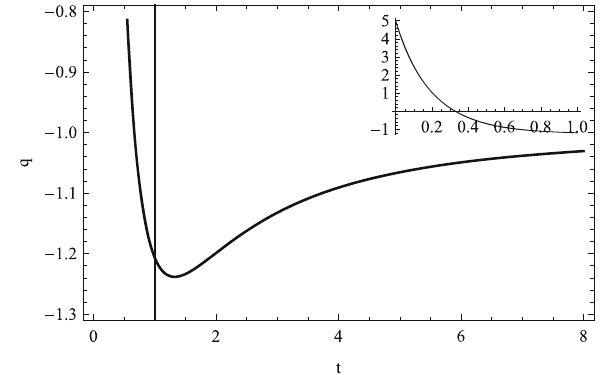
Fig. 3 Plot of the deceleration parameter versus the time t for the values of h 0 = 1 and V 0 = 0 . 28. The vertical line shows the present